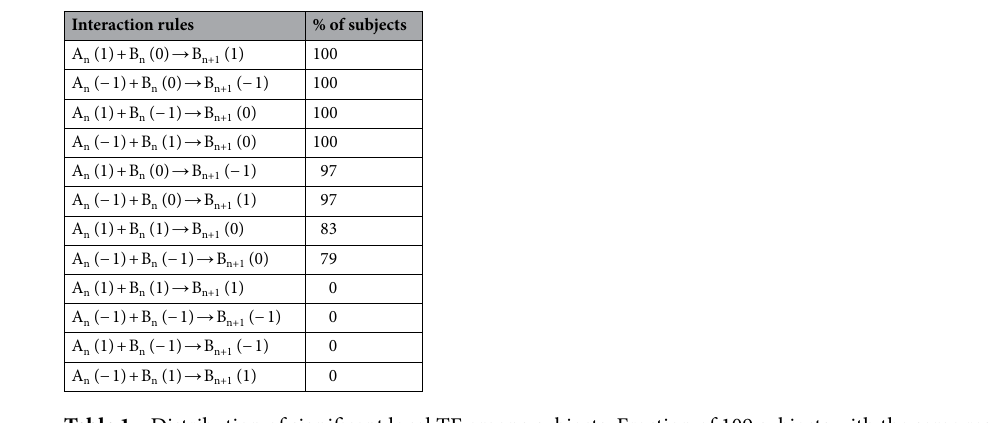
Table 1. Distribution of significant local TE among subjects. Fraction of 109 subjects with the same results for the different rules, p < 0.0001 Bonferroni corrected (157 repetitions).